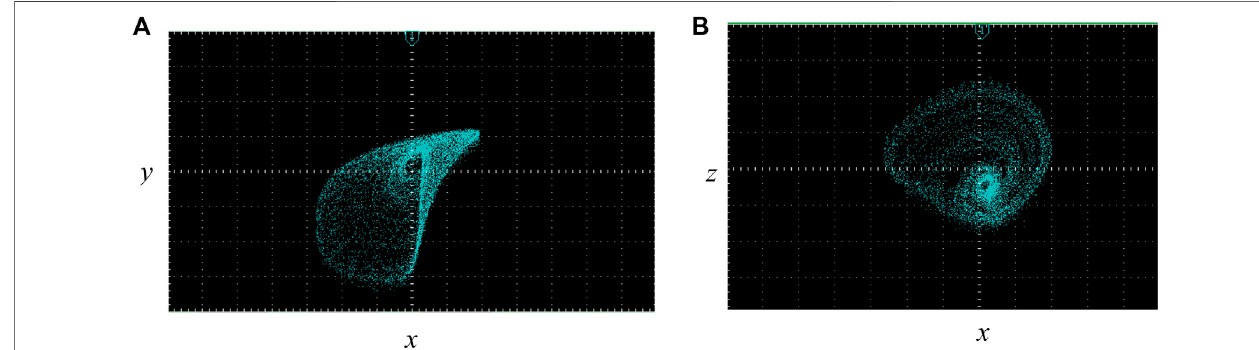
FIGURE 15 | Experimental results of DSP implementation. (A) x – y plane; (B) x – w plane.